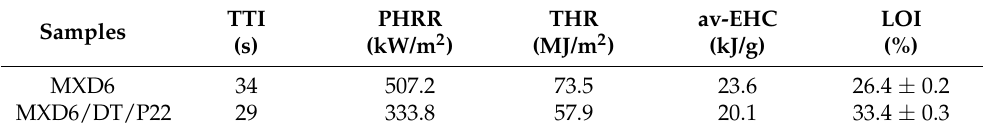
Table 4. The LOI and CCT data of neat MXD6 and MXD6/DT/P22.